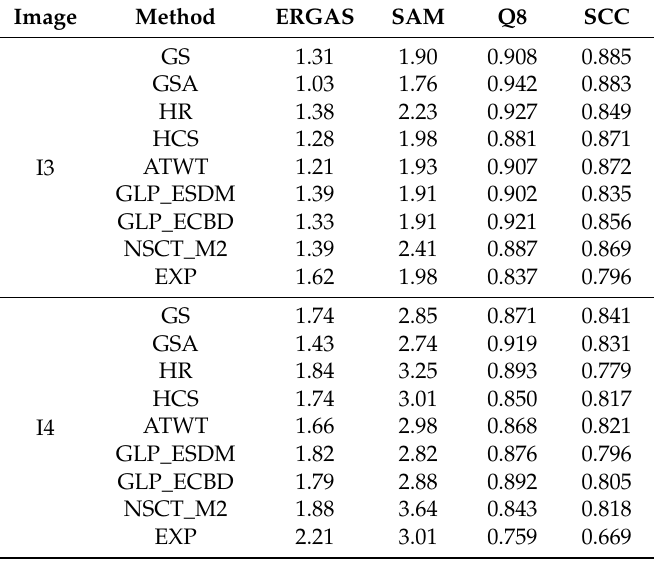
Table 3. Quality indices of the fused images generated by the selected algorithms for the two suburban